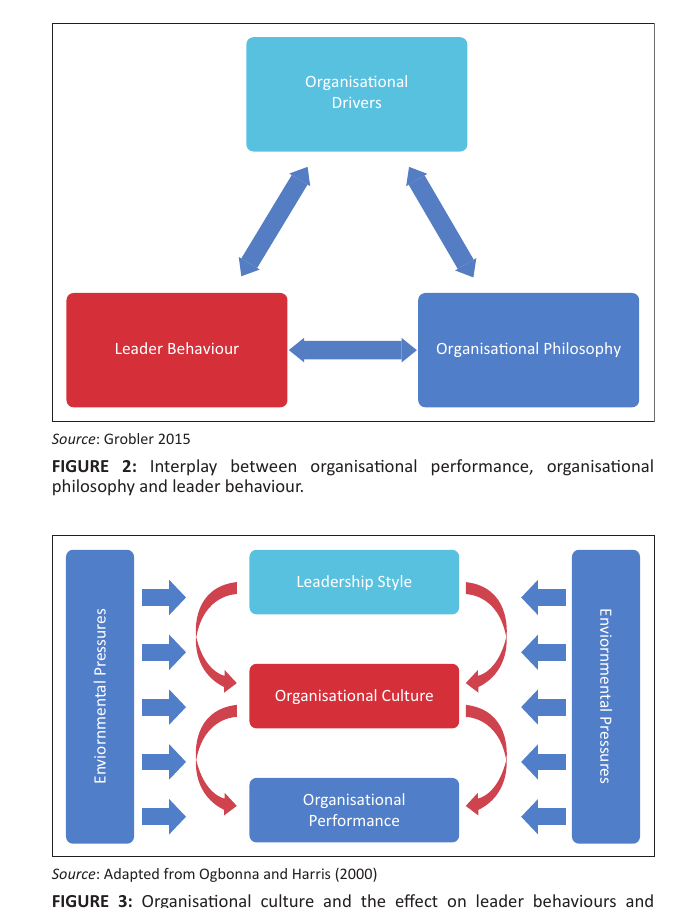
FIGURE 3: Organisational culture and the effect on leader behaviours and organisational